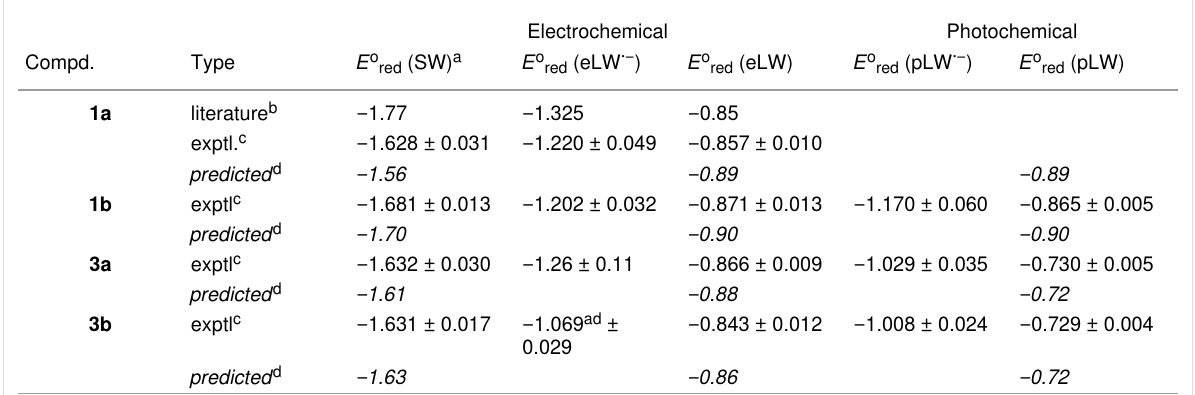
Table 1: Experimental and computational E o red of 1a , b and 3a , b and their LW isomers, reported in V vs SCE.